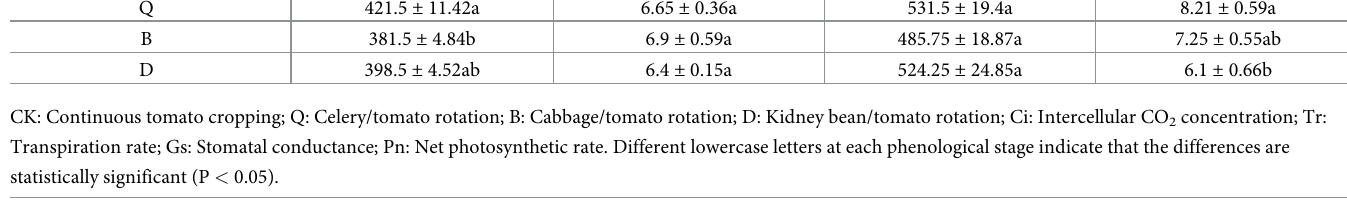
Table 2. Effects of different vegetable rotations on light and photosynthetic parameters of the tomato leaves. Cropping system